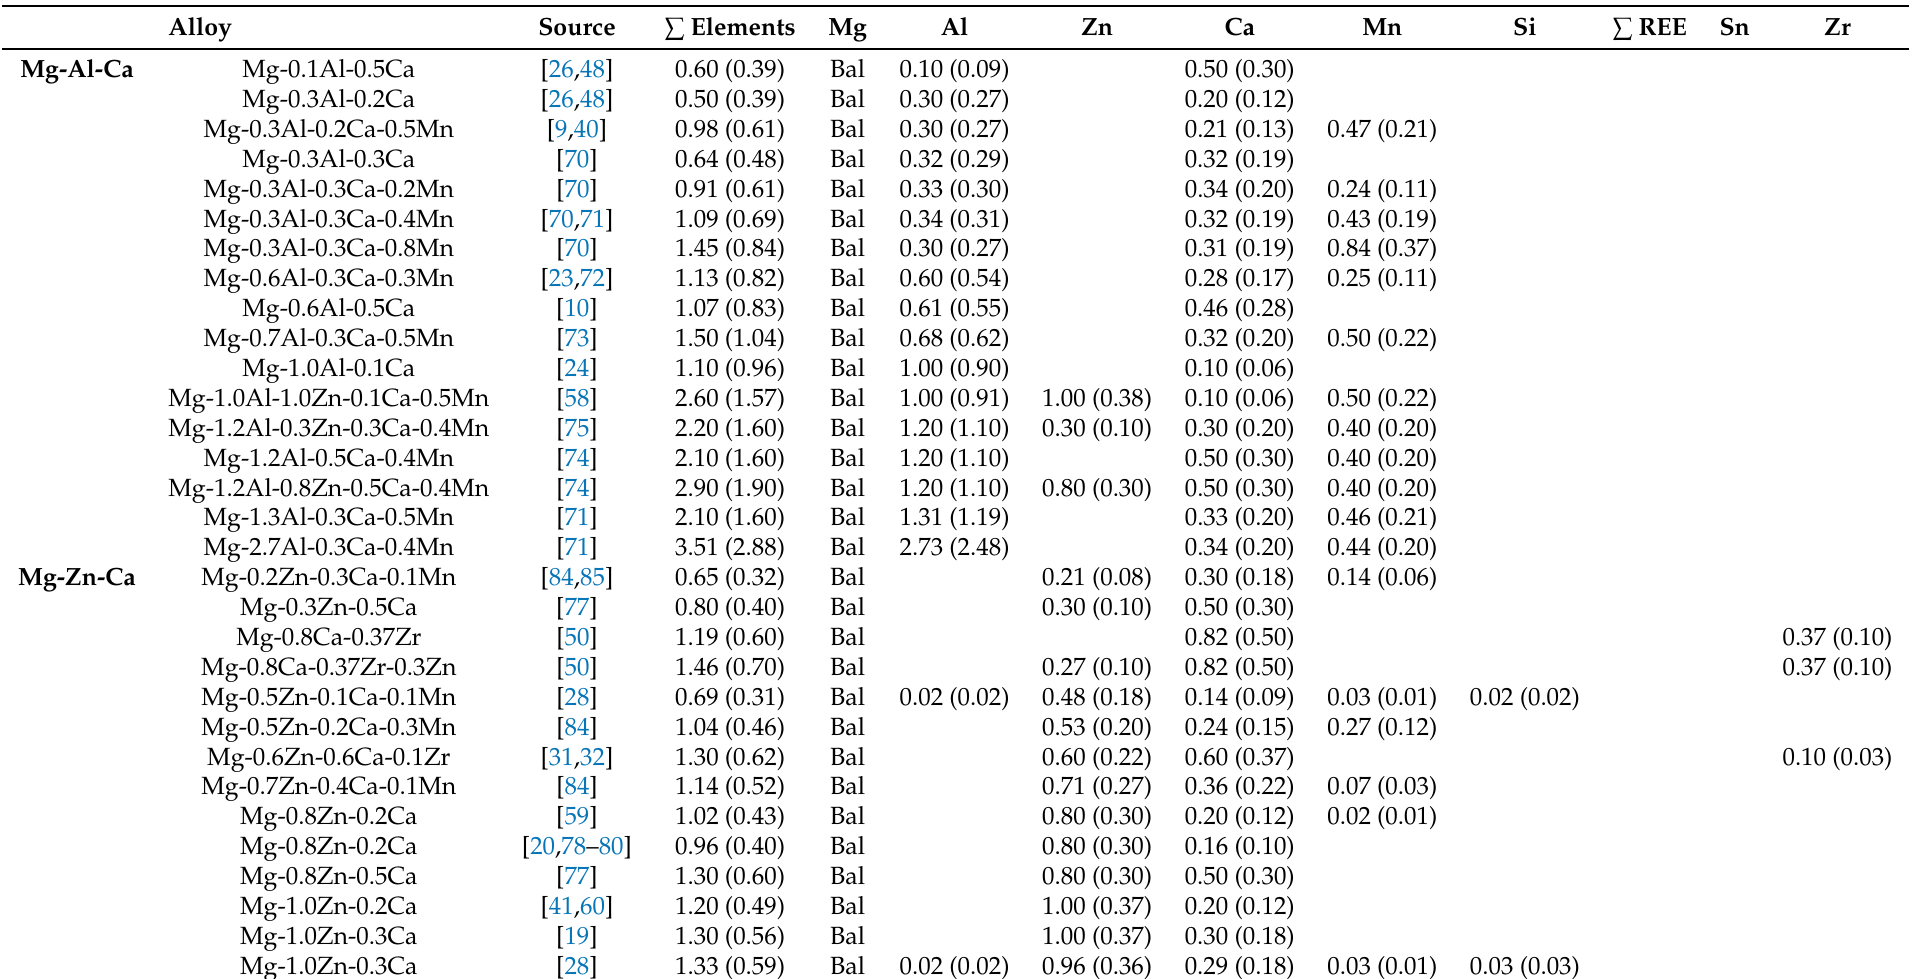
Table A1. Chemical composition of alloys discussed in the reviewed works, given in wt.% and (at.%). Alloying content below 0.01% (100ppm) is not listed; the RE elements are combined into a single column for improved